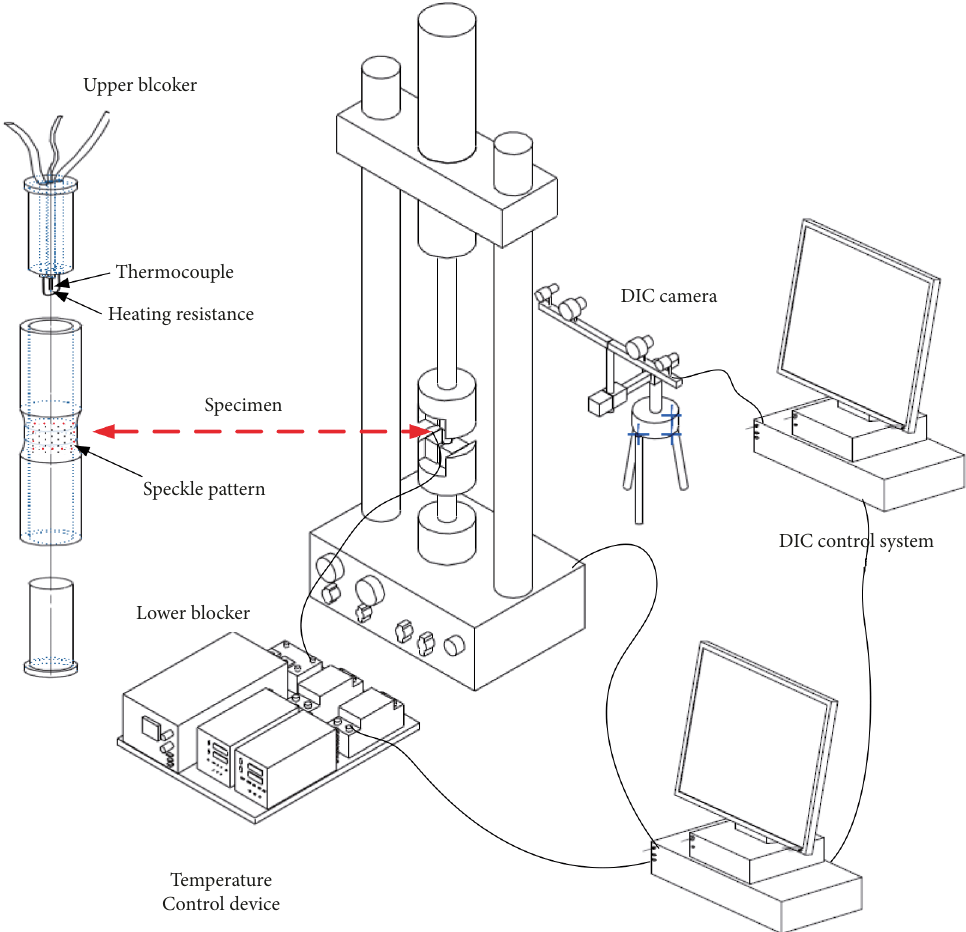
Figure 1: The schematic diagram of the proposed experimental method.